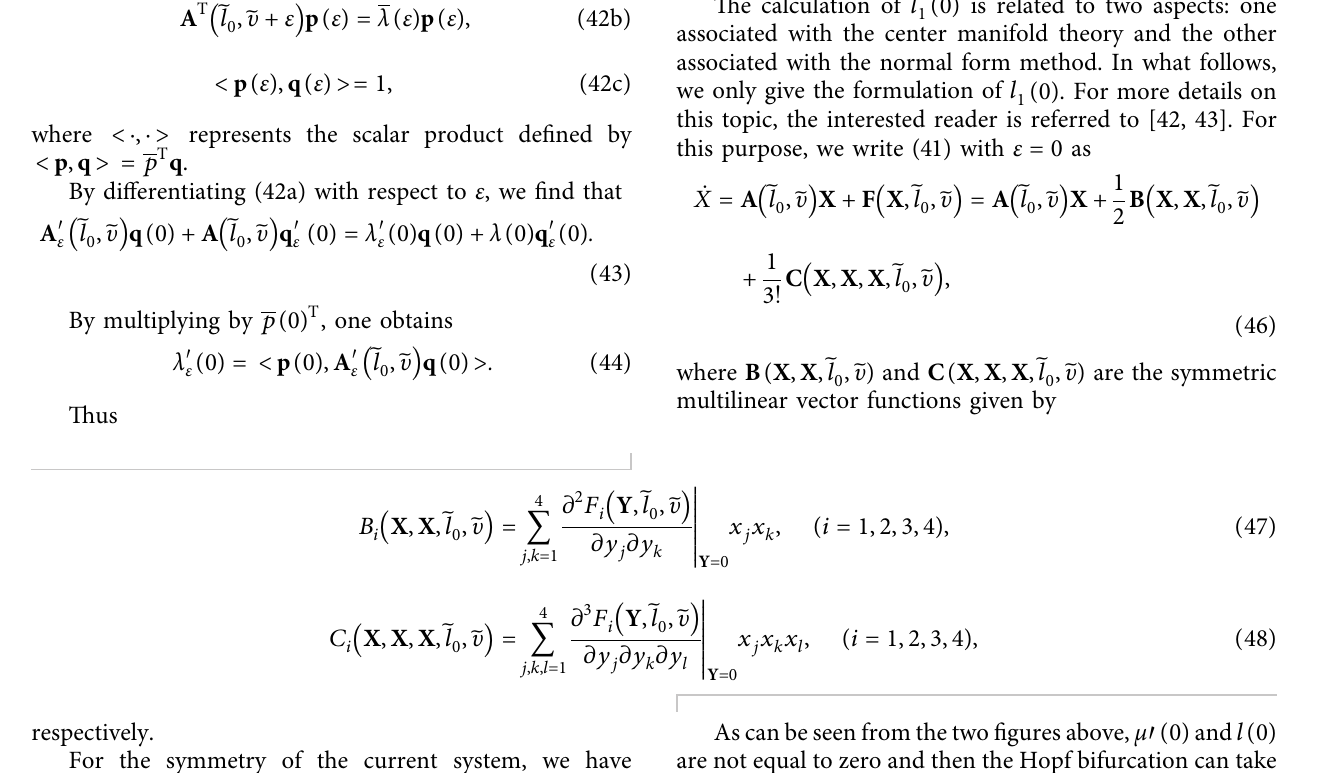
Figure 2: For the system defined by (38) with α � 0 . 005 , β � 0 . 2 , ξ � A l 2 G / ( 2EI ) quantity l defined by l p 0 0